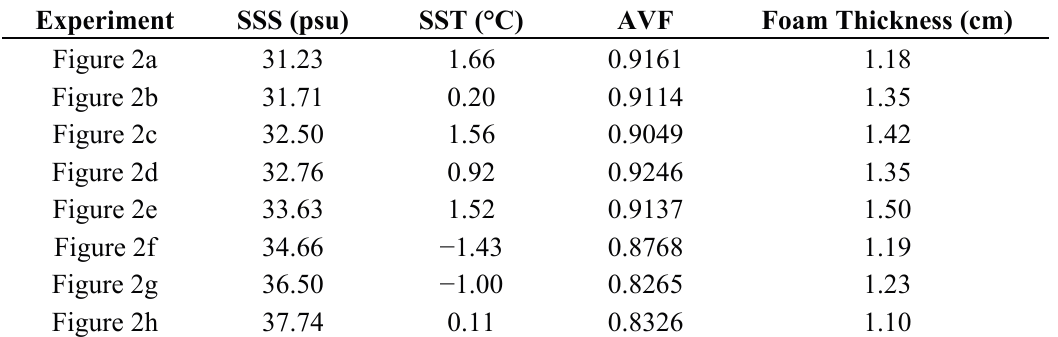
Table 2. Measured parameters of Figure 2 and tuning AVF used in RM emissivity model. Experiment